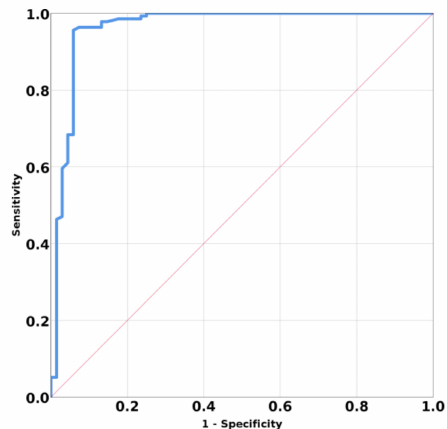
Figure 6. Mean SWE elastography values for parathyroid tissue compared with surrounding